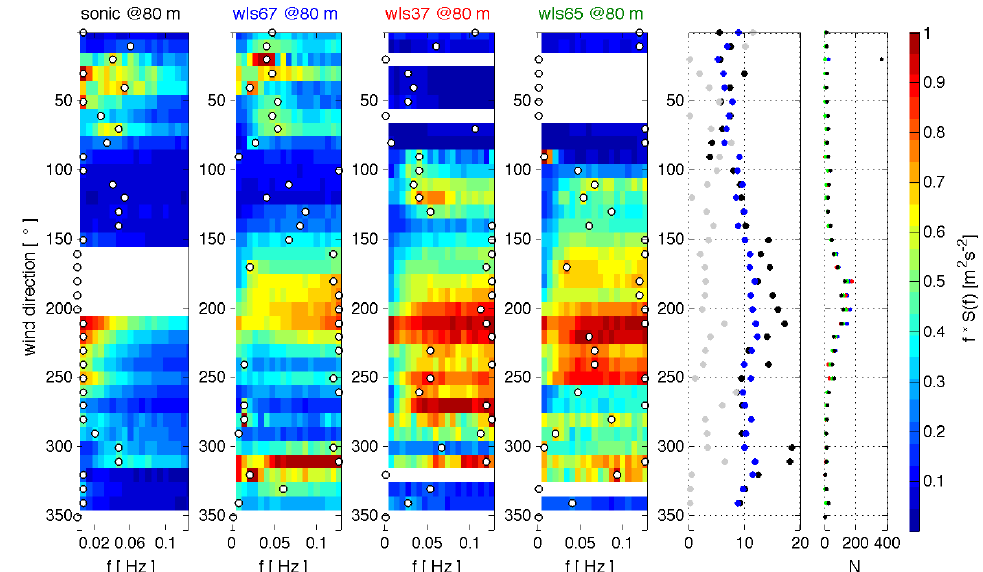
Figure 13. Composites of hourly energy spectra of u at 80m for all wind direction bins from wls67, wls37 and wls65 (from left to right) filtered for neutral wind conditions. White circles indicate the maximal spectral energy density of each direction bin. Additional subplots show wind direction bin averaged horizontal wind speeds at 108m (blue in (m · s − 1 )), power output (black in (MW/100)) and blade pitch angle (gray in ( ◦ )) of wind turbine WT6 and the number of averaged hours in each bin for wls67 (blue), wls37 (red) and wls65 (green).